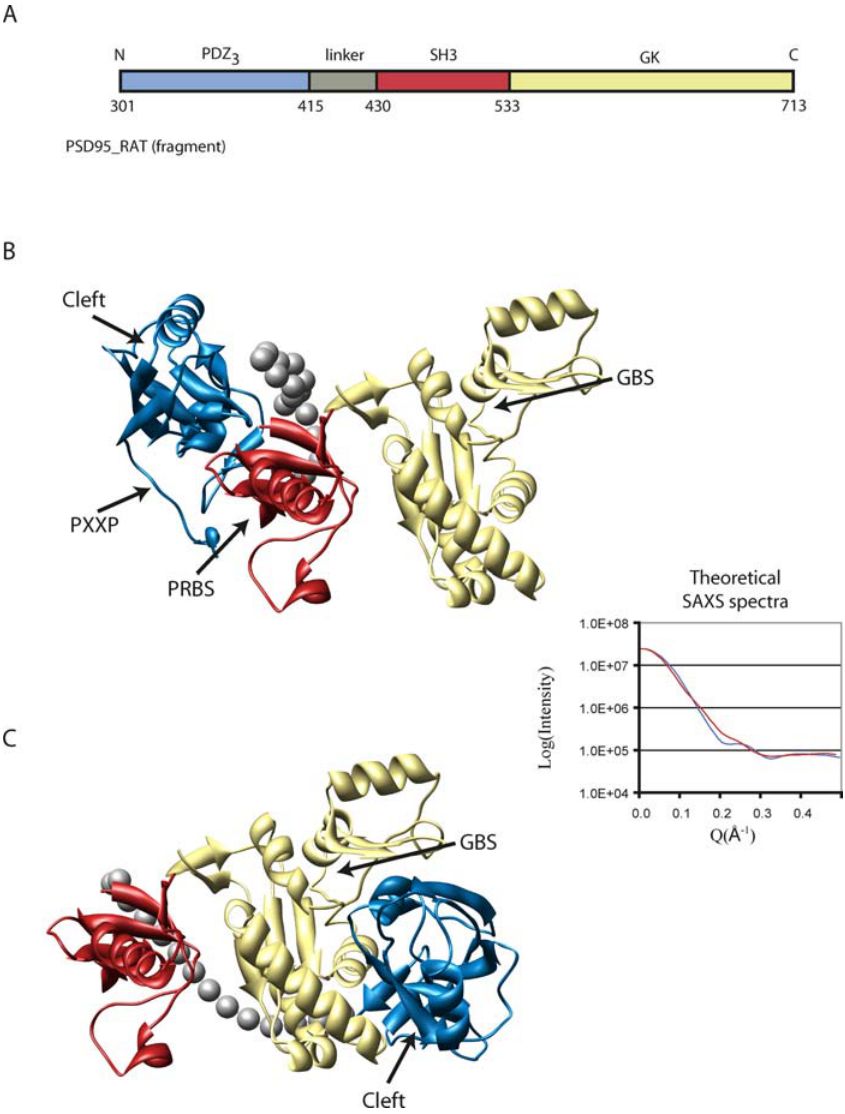
Figure 3. Two Binding Modes of the Core Fragment of Rat PSD-95 The PDZ 3 domain is shown in blue, SH3 in red, and GK in yellow. The grey spheres correspond to the residues of the interdomain linker between PDZ 3 and SH3. Locations of the hydrophobic cleft (Cleft) and PXXP motif (PXXP) in PDZ 3 , PRBS in SH3, and the GBS in GK are shown by arrows. (A) The domain architecture of the core fragment. (B) The first predicted configuration. (C) The second predicted configuration. The difference between the theoretically calculated SAXS spectra of the first (red) and second (blue) configurations is significantly larger than the anticipated experimental